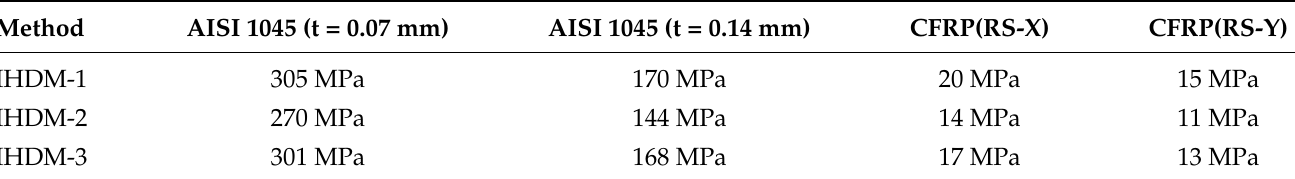
Table 3. Surface residual